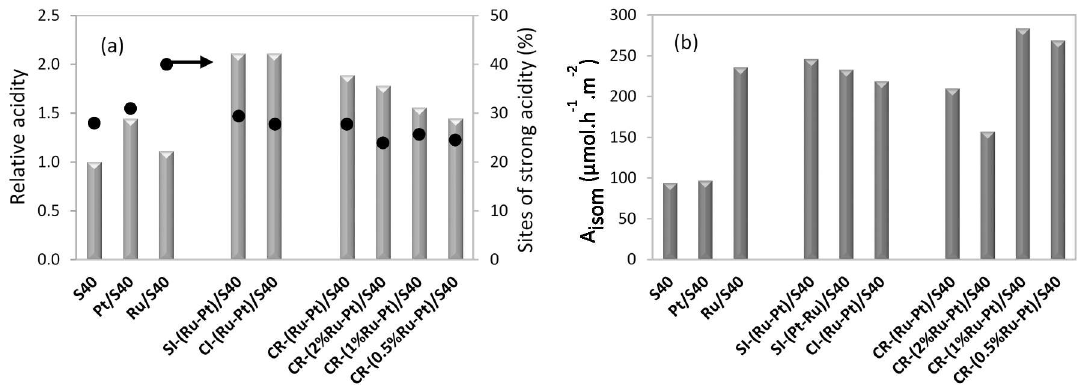
Figure 5. Acidic properties of the Ru–Pt/S40 bimetallic catalysts prepared by co-impregnation (CI), successive impregnations (SI) or catalytic reduction deposition (CR), and of the corresponding monometallic samples: ( a ) Relative total acidity measured by NH 3 –TPD considering a total acidity of 1 μmol m -2 for S40 support, and the percentage of sites of strong acidity; ( b ) activity for isomerization of 33DMB1 at 130 °C.